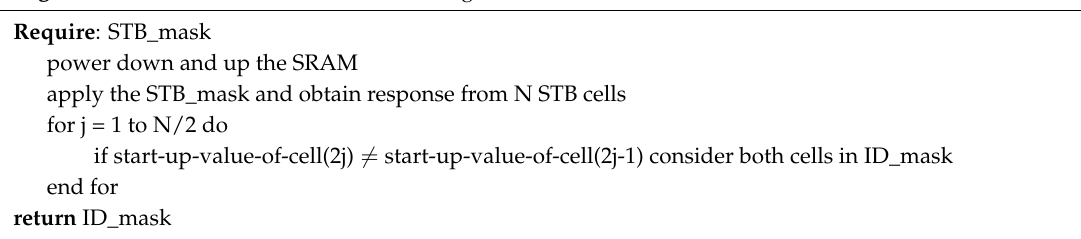
Algorithm 2 Pseudo-code of 2O-VN